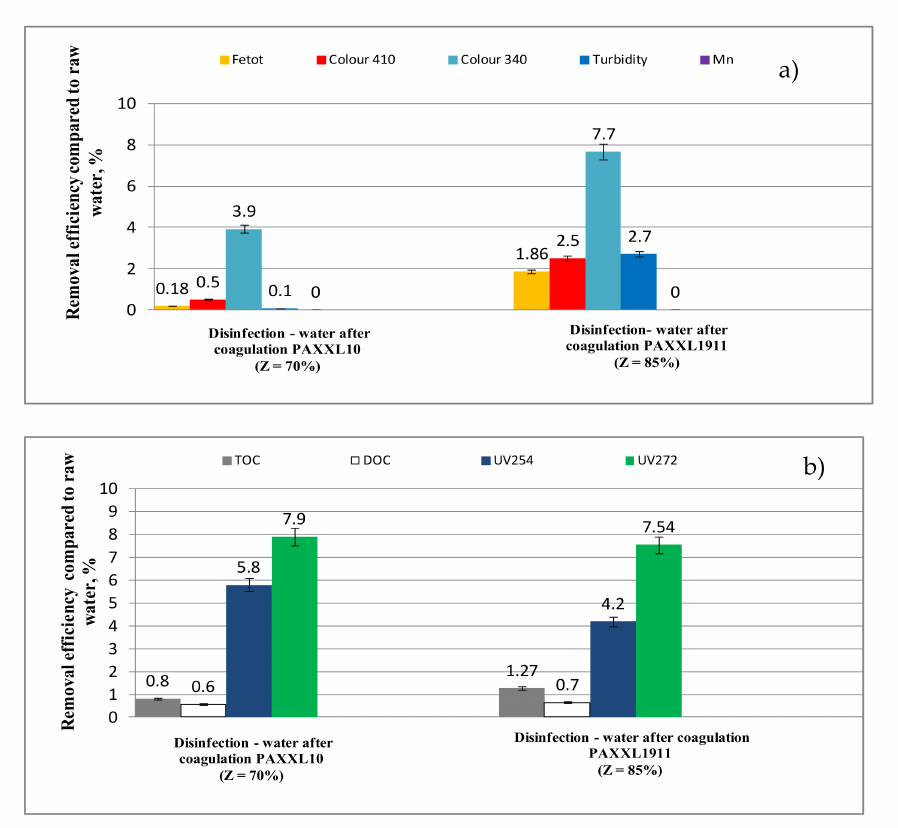
Figure 10. Efficiency of iron total, colour at wavelength 410 nm and 340 nm, turbidity, manganese ( a ) and TOC, DOC, UV 254 , UV 272 ( b ) removal from water by